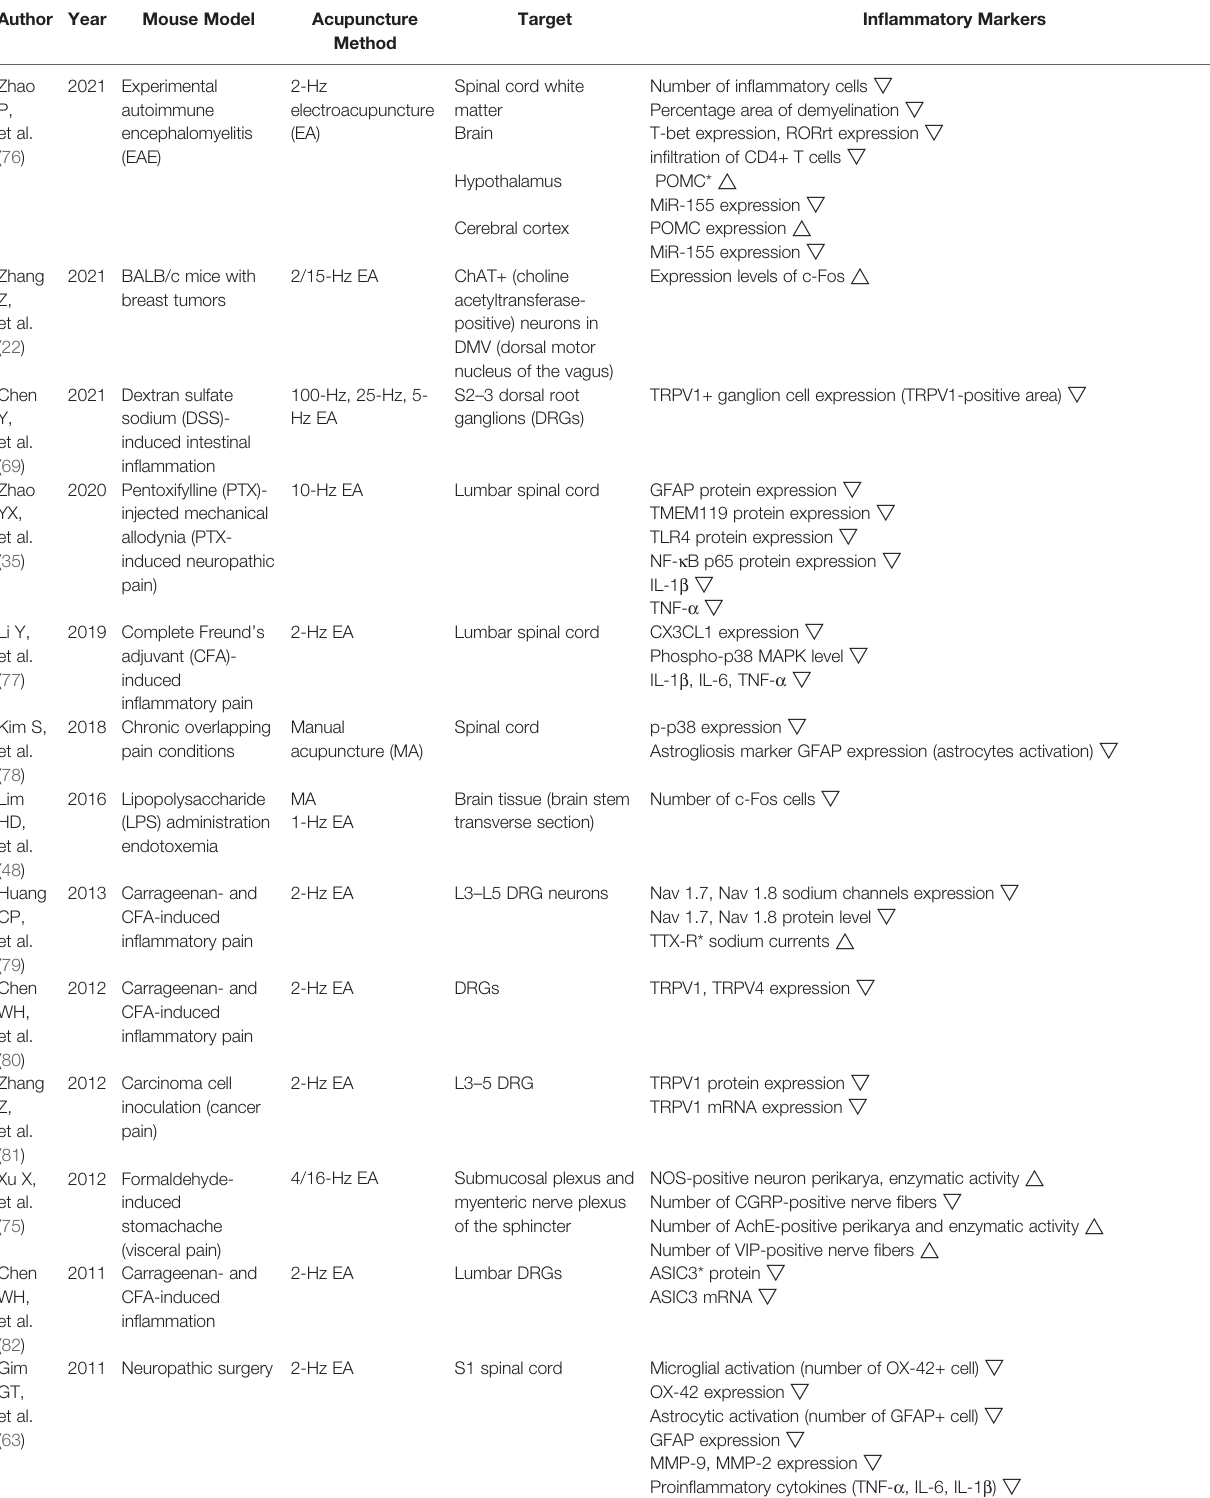
TABLE 3 | Anti-in fl ammatory effect of acupuncture on ST36 in nervous